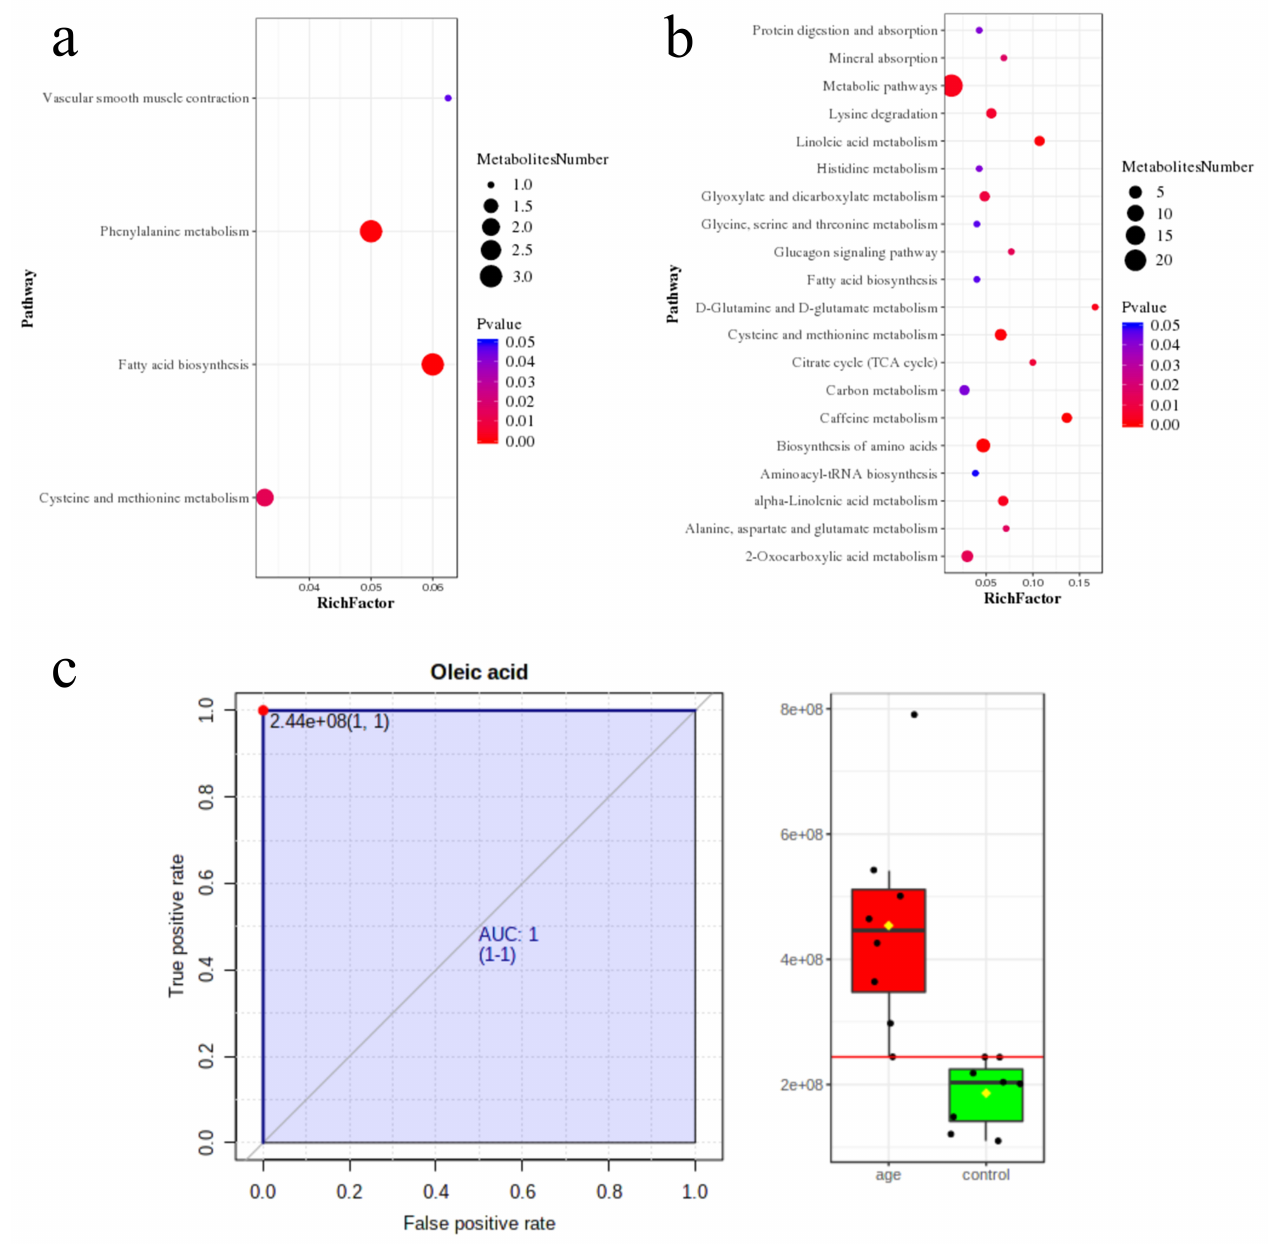
Figure 4. Untargeted metabolomics pathway analysis. ( a ) The pathway enrichment analysis in negative mode. ( b ) The pathway enrichment analysis in positive mode. The color and size of each circle was based on the p -value and pathway impact value, respectively. ( c ) The ROC analysis of oleic acid for differentiating the aging group from the